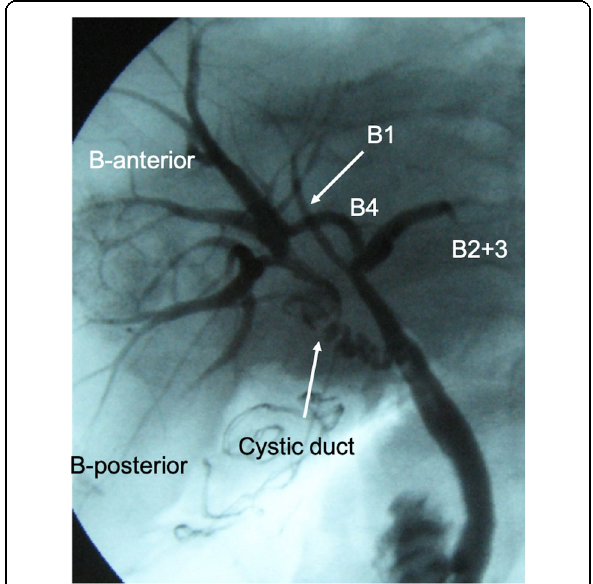
Fig. 2 Intraoperative cholangiography revealed the main right hepatic duct entering the cystic